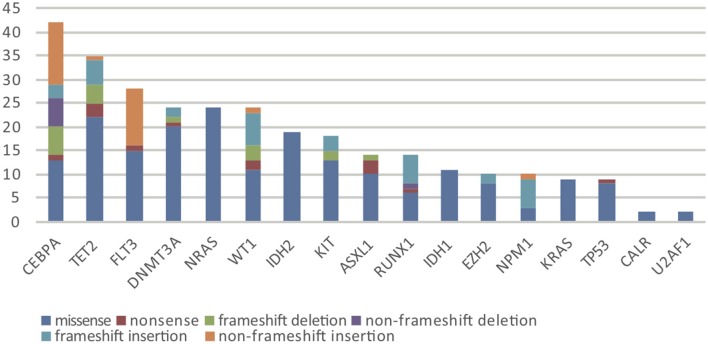
The number and subtype distribution of the 17 gene variants included in the AML NGS panel. Each variant subtype is marked with a unique color. Y axis represents the variant number (N) of each gene.